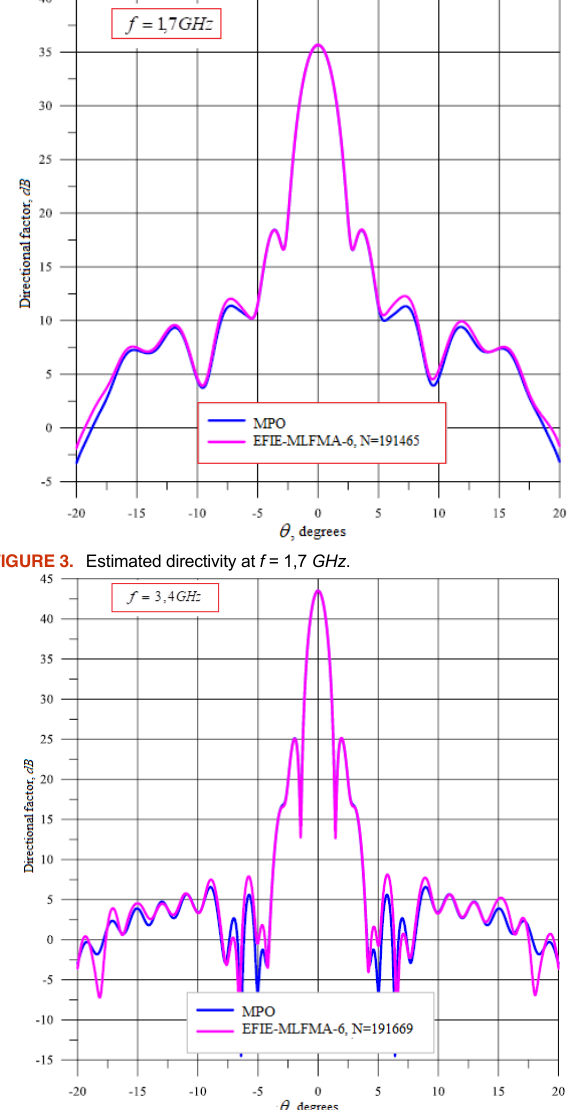
FIGURE 4. Estimated directivity at f = 3,4 GHz .